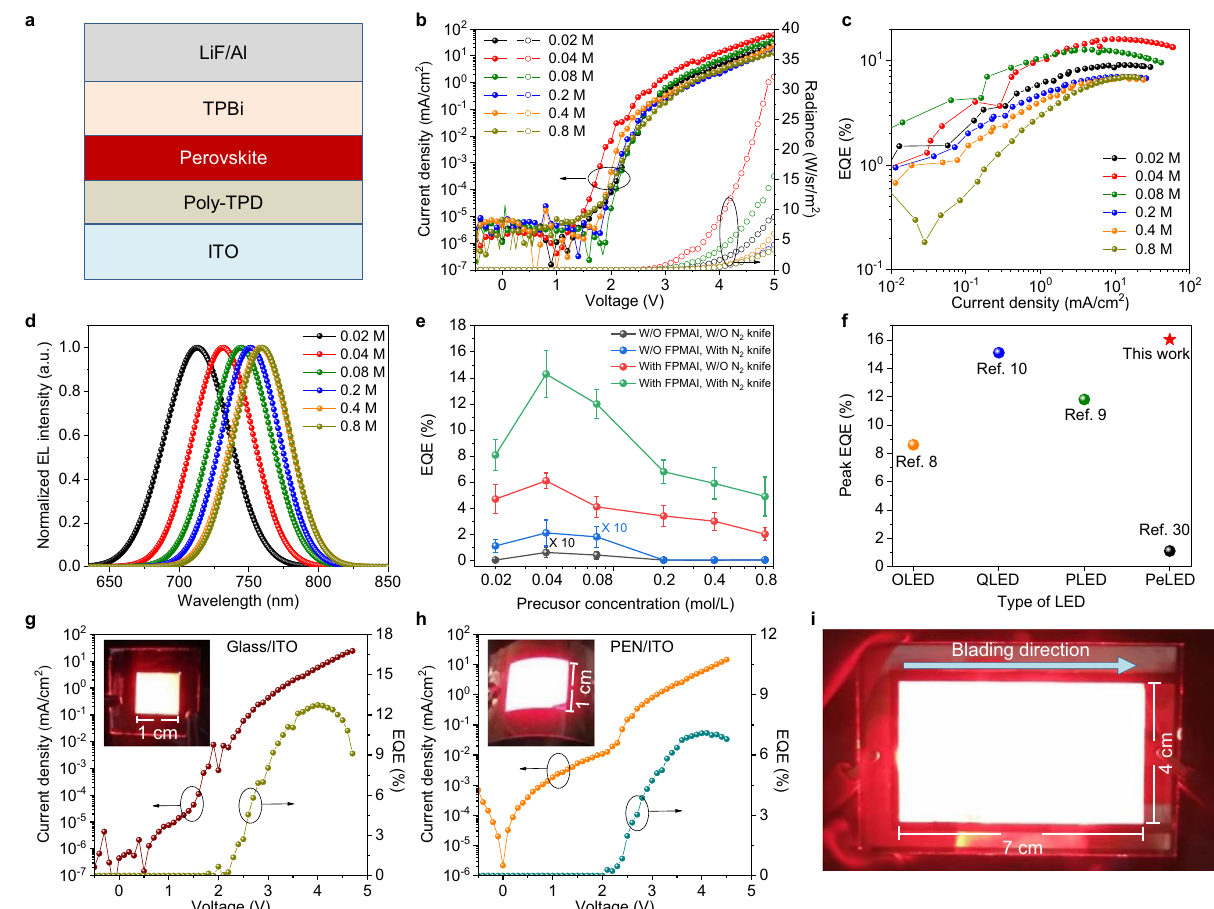
Fig. 5 Performance of doctor-bladed PeLEDs. a Device structure of PeLEDs. b – d Current density – voltage – radiance ( J – V – R ) curves ( b ), EQE ( c ), and EL spectra ( d ) of the PeLEDs fabricated with FPMAI additive and N 2 knife. e EQE statistics of the PeLEDs fabricated by different methods. The EQE statistics of PeLEDs made from 0.04 M solution with FPMAI additive and N 2 knife is based on 20 devices, and other categories are based on 10 devices. Error bars represent standard deviation. f Comparison of the peak EQE of OLEDs, QLEDs, PLEDs, and PeLEDs fabricated by blade-coating. g , h Current density and EQE curves of doctor-bladed PeLEDs on glass/ITO ( g ) and PEN/ITO ( h ) with a device area of 1 × 1 cm 2 . Inset is photo image of the PeLED. i Photo image of an ultra large-area PeLED with a device area of 4 × 7 cm 2